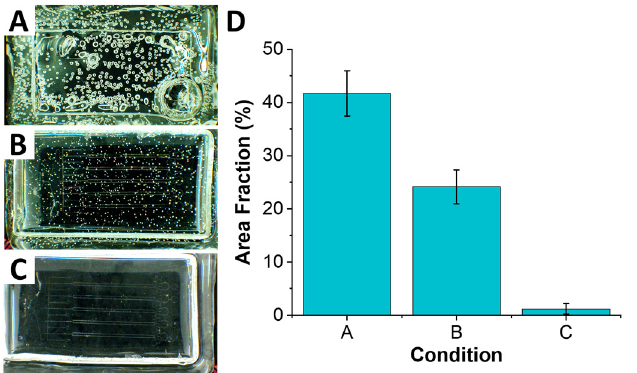
Figure 2. Impact of the drying process and thermal stress on fabrication of PC masters. ( A ) PCM not dried and subjected to thermal stress. ( B ) PCM not dried and not subjected to thermal stress. ( C ) PCM dried for 2 h at 125 ◦ C and vacuum at ~49 mm Hg and not subjected to thermal stress. ( D ) Quantitative comparison of the area occupied by bubbles in PCM in scenarios ( A – C ) ( n = 3). Drying PC before baking and avoiding thermal stress by placing PC in the oven below its glass transition temperature were found to be essential to avoid the formation of